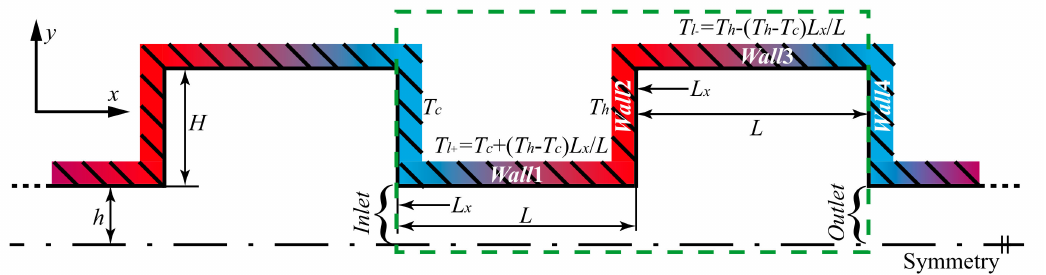
Figure 1. Configuration and geometric parameter.